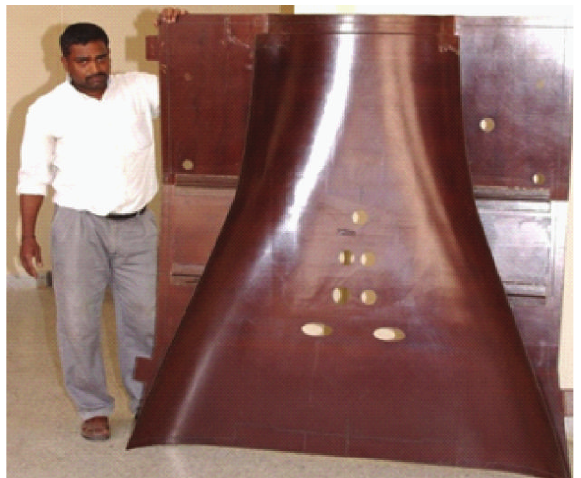
Figure 13: Trouser duct of LCA Aircraft cured in an autoclave at CSIR-NAL.